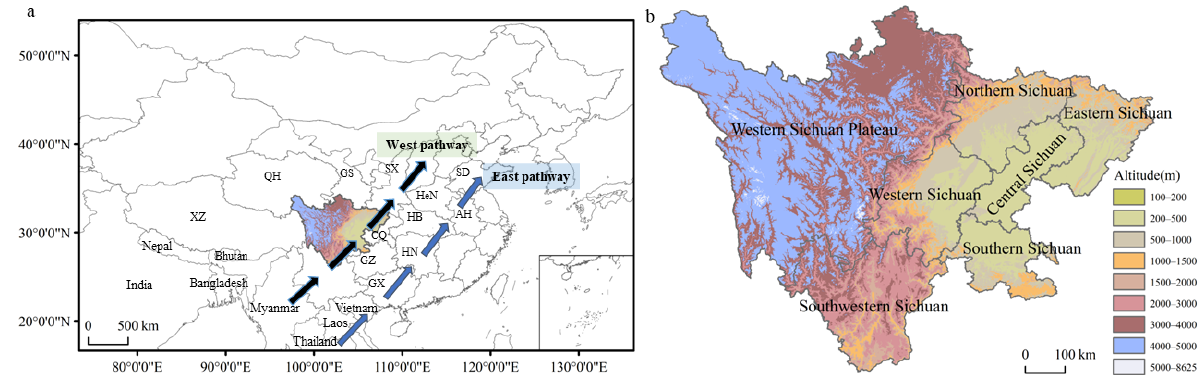
Figure 1. ( a ) The geographical location of Sichuan in China. Sichuan is on the western migratory pathway of FAWs. ( b ) Topography and divisions of Sichuan Province. Sichuan Province is divided into seven topographic regions: southwestern Sichuan, where FAWs can breed year-round in the subtropical areas of this region; western Sichuan Plateau, where FAWs occur sporadically as less than one generation; and the other five regions, i.e., southern Sichuan, western Sichuan, central Sichuan, northern Sichuan and eastern Sichuan, which compose the Sichuan Basin and its surroundings with hills and mountains. Two-letter codes refer to the different provinces of China (XZ: Tibetan Autonomous Region, QH: Qinghai Province, GS: Gansu Province, SX: Shannxi, HeN: Henan